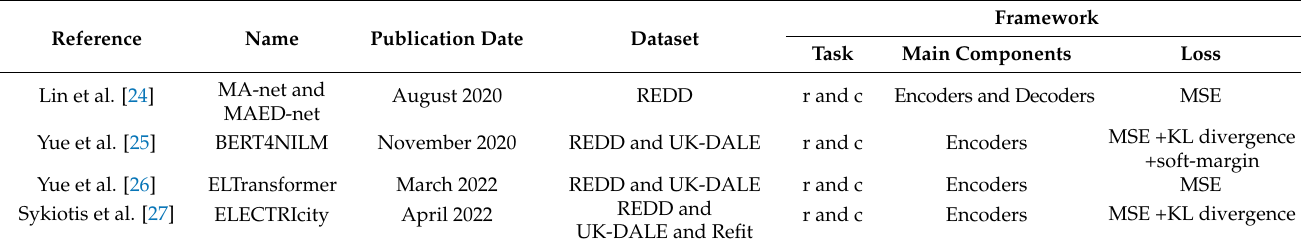
Table 1. Comparison of Transformer-based NILM